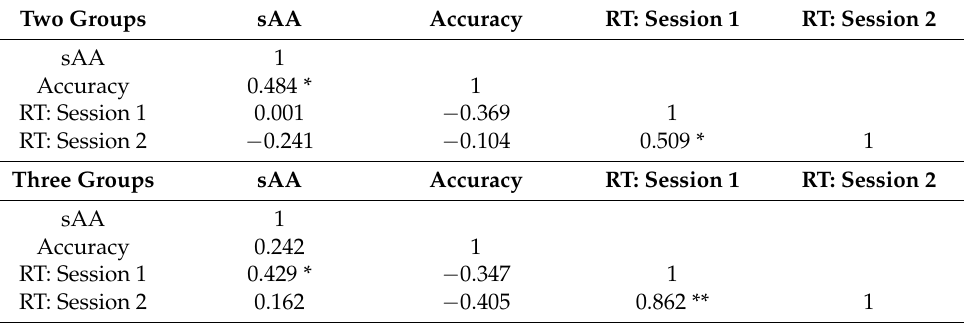
Table 3. Pearson correlation coefficients between stress scales (sAA) and behavioral results (accuracy or response times (RT)): Scale validity of Pearson correlation for two groups (n = 44) and three groups (n = 33). Two groups show a significant positive correlation between sAA and accuracy. However, three groups exhibit a positive correlation between sAA and RT: Session 1. Although the other results do not show statistically significant differences, they suggest another possibility of classifying stress levels between eustress and distress groups.